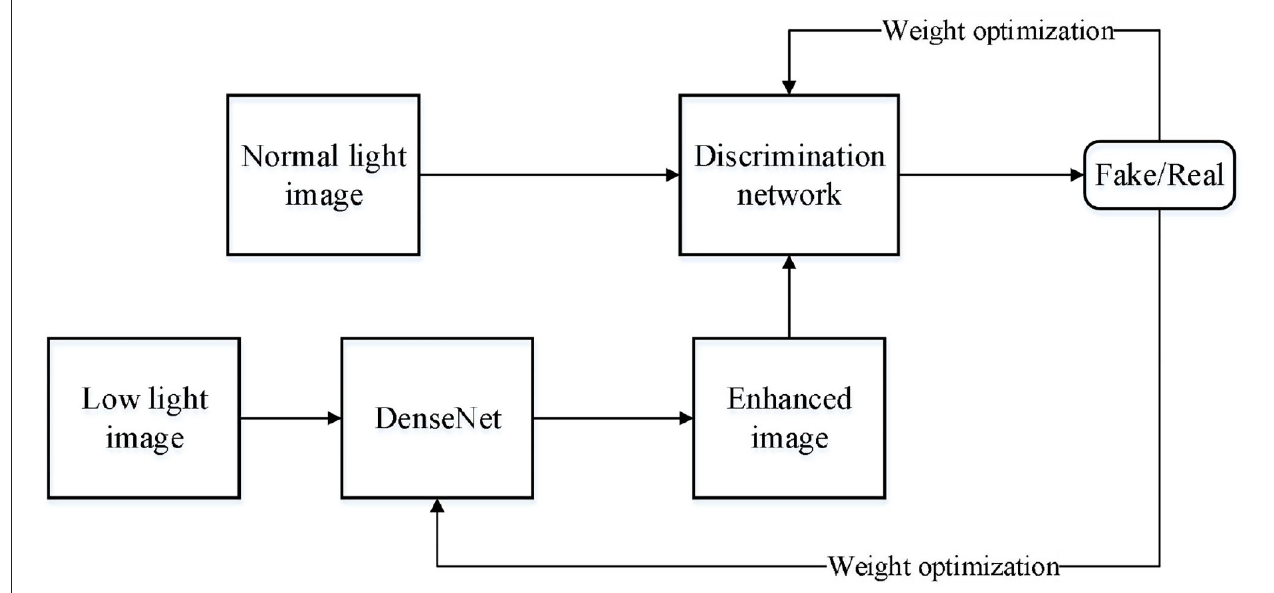
FIGURE 4 | Proposed low-light image enhancement model based on DNGAN.